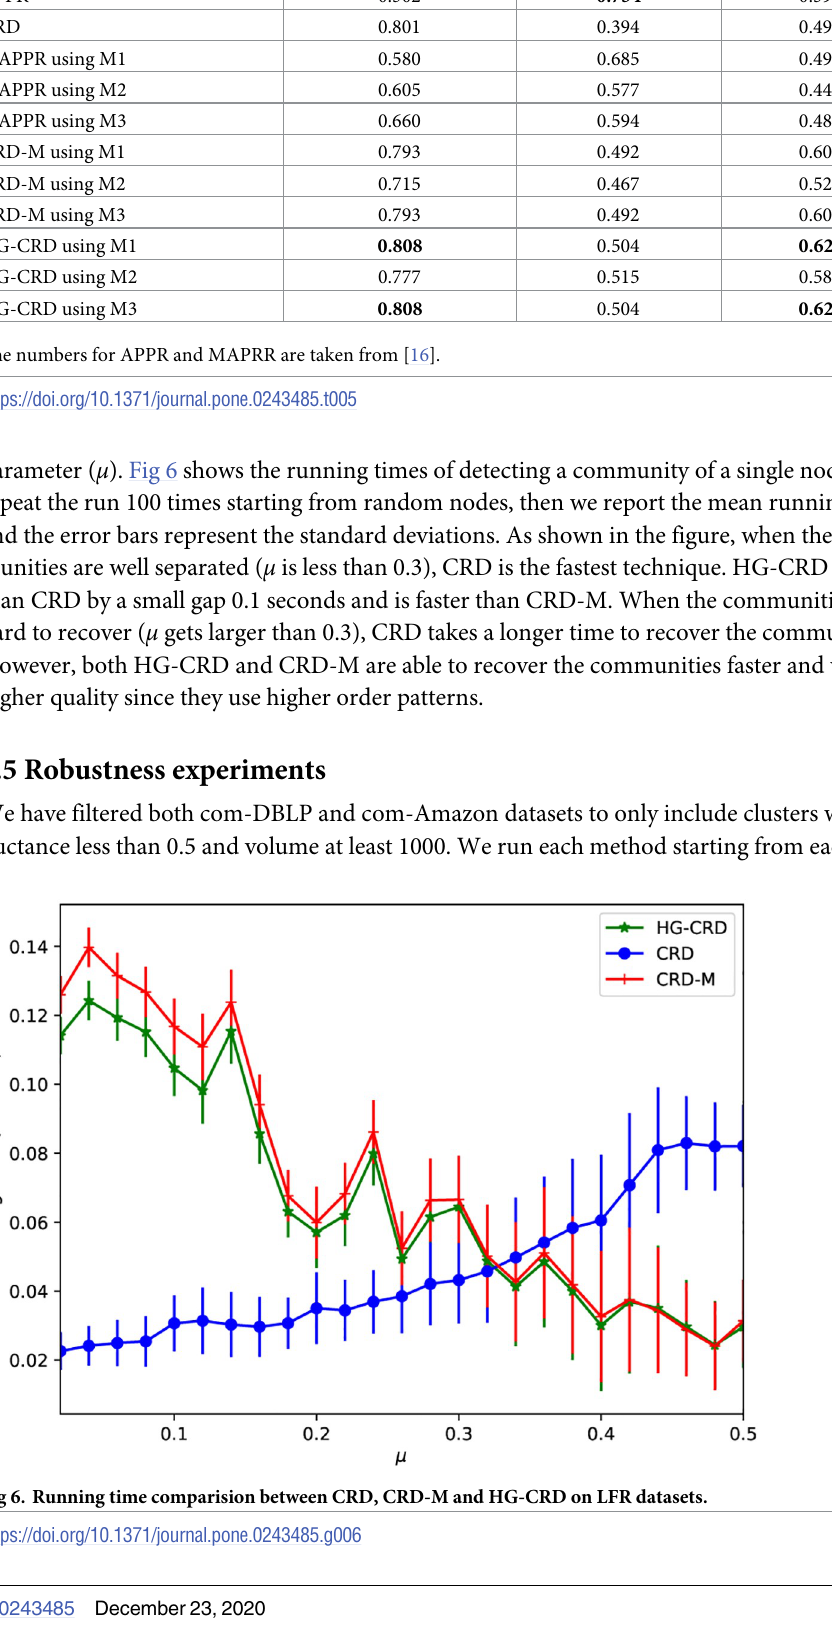
Table 5. Comparison between higher order CRD (HG-CRD) and motif-based approximate personalized pageRank (MAPPR) on directed Email-EU graph. Precision Recall F 1 APPR